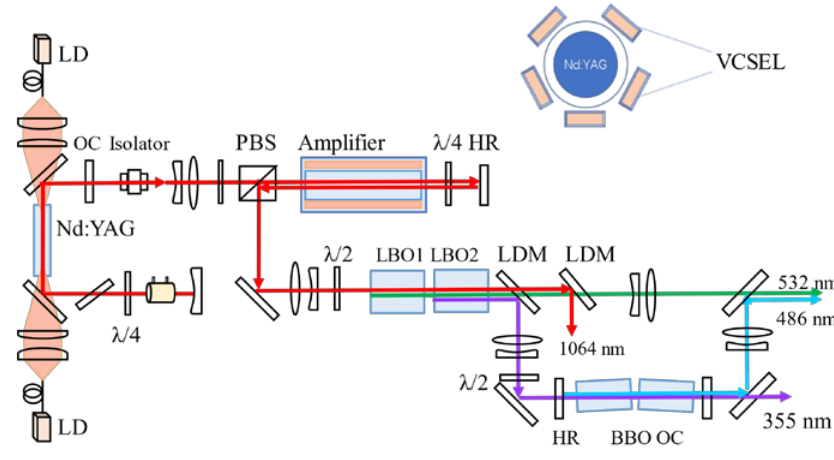
Figure 2. Schematic diagram of the 486 and 532 nm lasers.